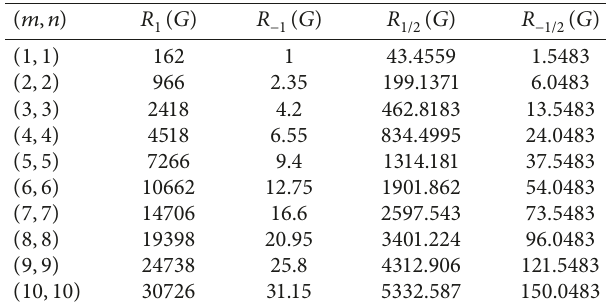
Table 6: Connection between the R R